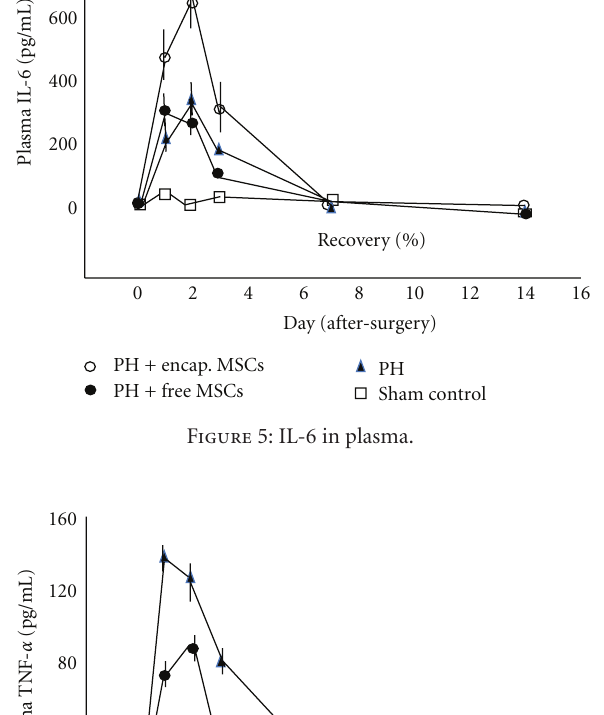
Figure 3: Remnant liver wet weight on day 14.